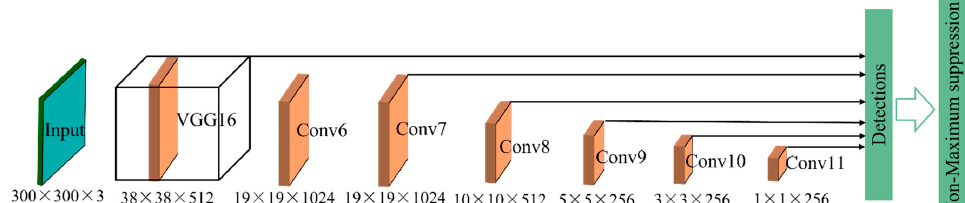
Figure 9. The model architecture of the SSD